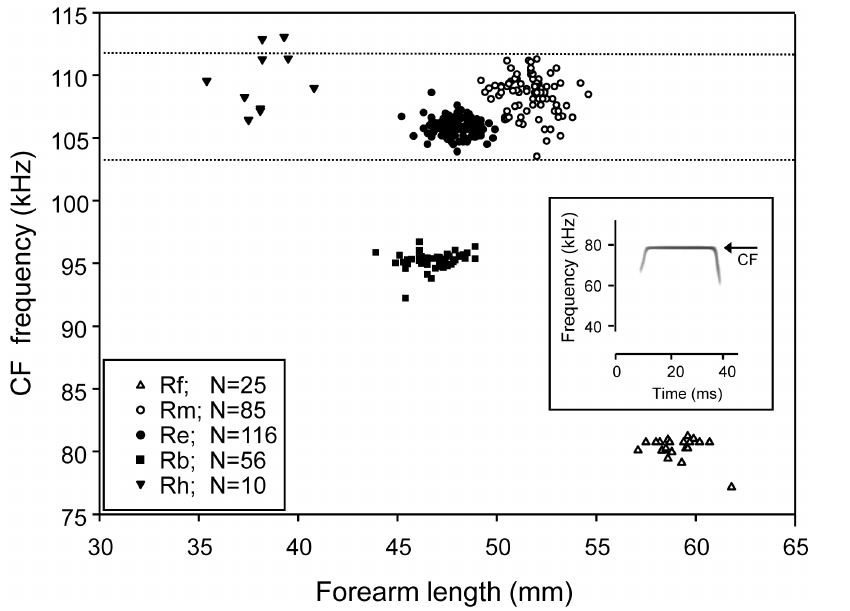
Figure 1. CF frequencies of sympatric horseshoe bats from Bulgaria are plotted against forearm length, the standard size measure in bats, for Rhinolophusferrumequinum (Rf, N=25), R.blasii (Rb, N=56), R.mehelyi (Rm, N=85), R.euryale (Re, N=116) and R. hipposideros (Rh, N=10). The peak echolocation call frequencies used by Rm strongly overlapped those of Re and Rh (dotted lines), while the bands used by Rf and Rb were clearly separated.